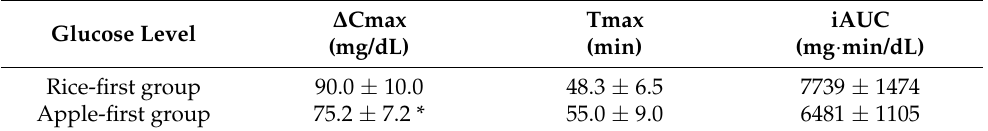
Table 3. Dynamic parameters of blood glucose levels in the impaired glucose tolerance subjects. ∆ Cmax Tmax iAUC Glucose Level (mg/dL) (min) (mg · min/dL) Rice-first group 90.0 ± 10.0 48.3 ± 6.5 7739 ± 1474 Apple-first group 75.2 ± 7.2 * 55.0 ± 9.0 6481 ±